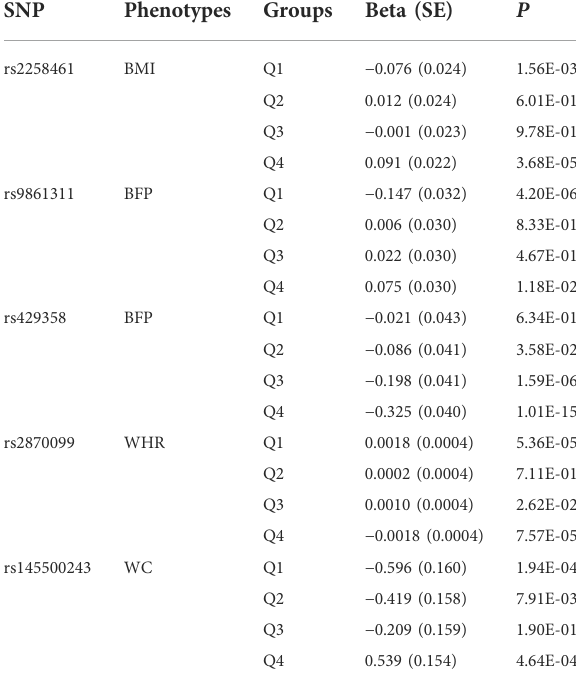
TABLE 3 The results of GWASs in each age